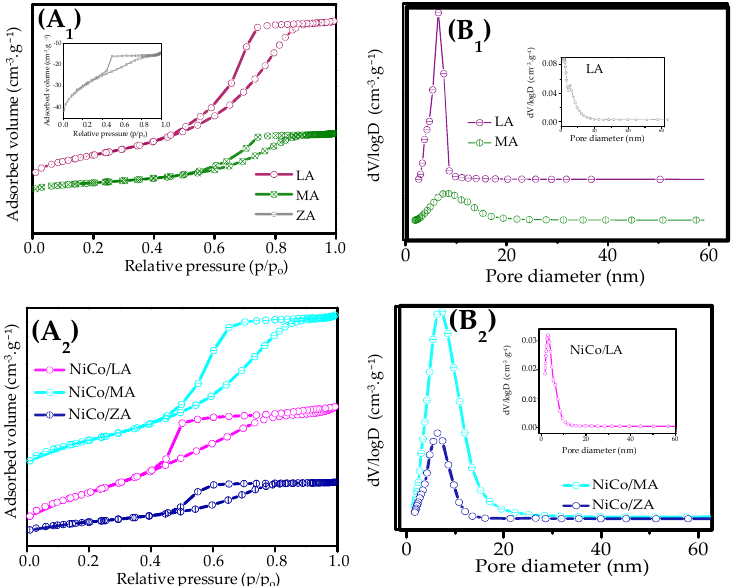
Figure 4. ( A ) N 2 physisorption analyses and the corresponding ( B ) pore size distributions of the supported and unsupported solids. The inset figure ( A 1 ) is the isotherm of the ZA sample, whereas insets ( B 1 , B 2 ) are the pore size distribution curves of ZA and NiCo/LA samples, respectively. The figure ( A 2 ) corresponds to the isotherms of the supported solids.